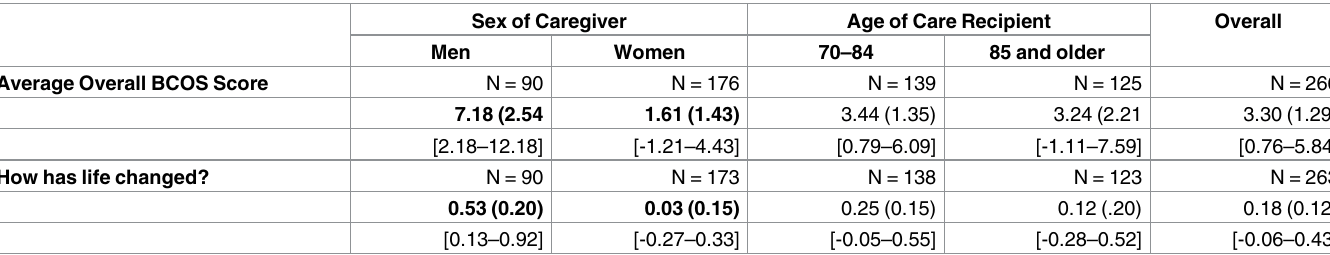
Table 7. Transportation caregiverburden by sex, age of care recipient, and statewide (standard error of the percent/mean) [95 th